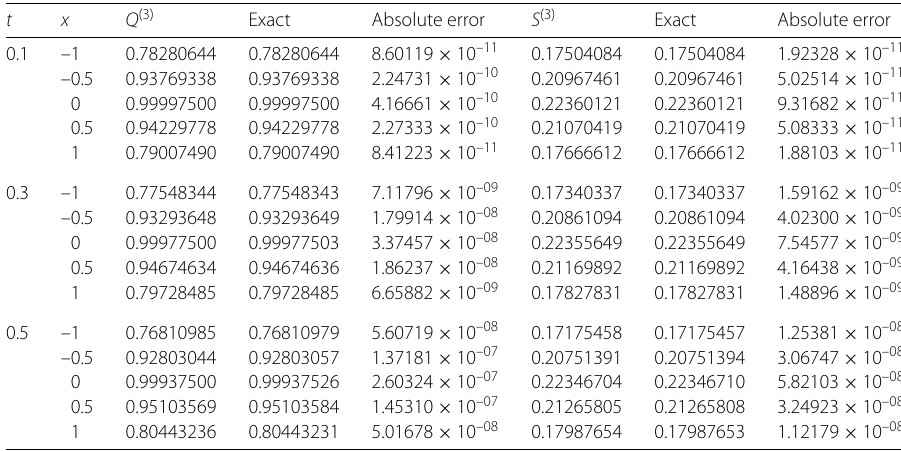
Table 2 The q-HATM solution for Q ( x , t ) and S ( x , t ) for the first three approximations in comparison with the exact solution Equation (46) when α = 1, (cid:2) = –1, A = r = 0.1, B = 3, and n = 1 for Example